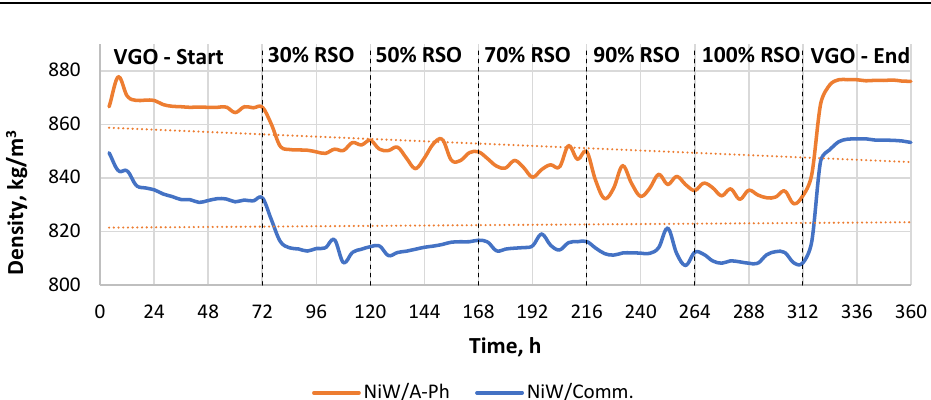
Figure 2. The density of the products throughout the experiment performed using two catalysts (NiW/A-Ph, NiW/Comm.). The experiment started by processing pure VGO, and then there were five feedstock blend changes using 30%, 50%, 70%, 90%, and 100% RSO, respectively. Table 2. Characteristics of the liquid products: elemental composition, H/C ratio, density, and water content of the products collected by processing each feedstock blend.